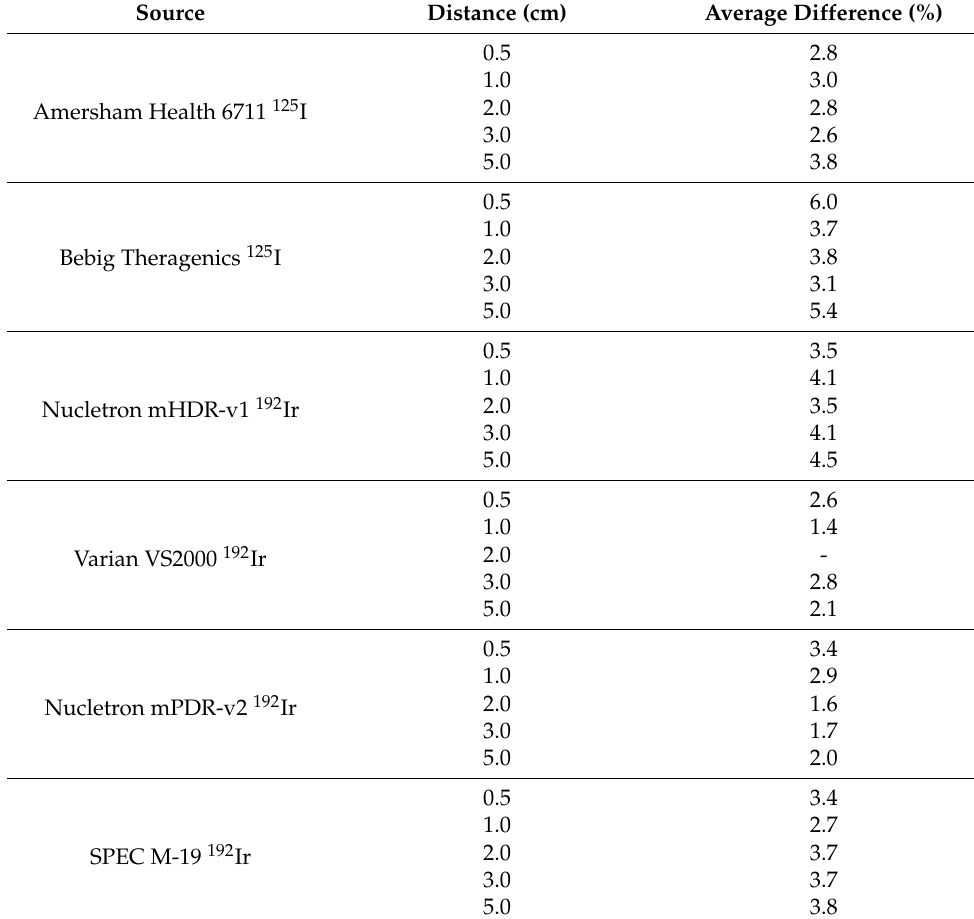
Table 1. Average Statistical Difference of Anisotropy Function, for all seeds, when simulation output is compared with TG-43 data.